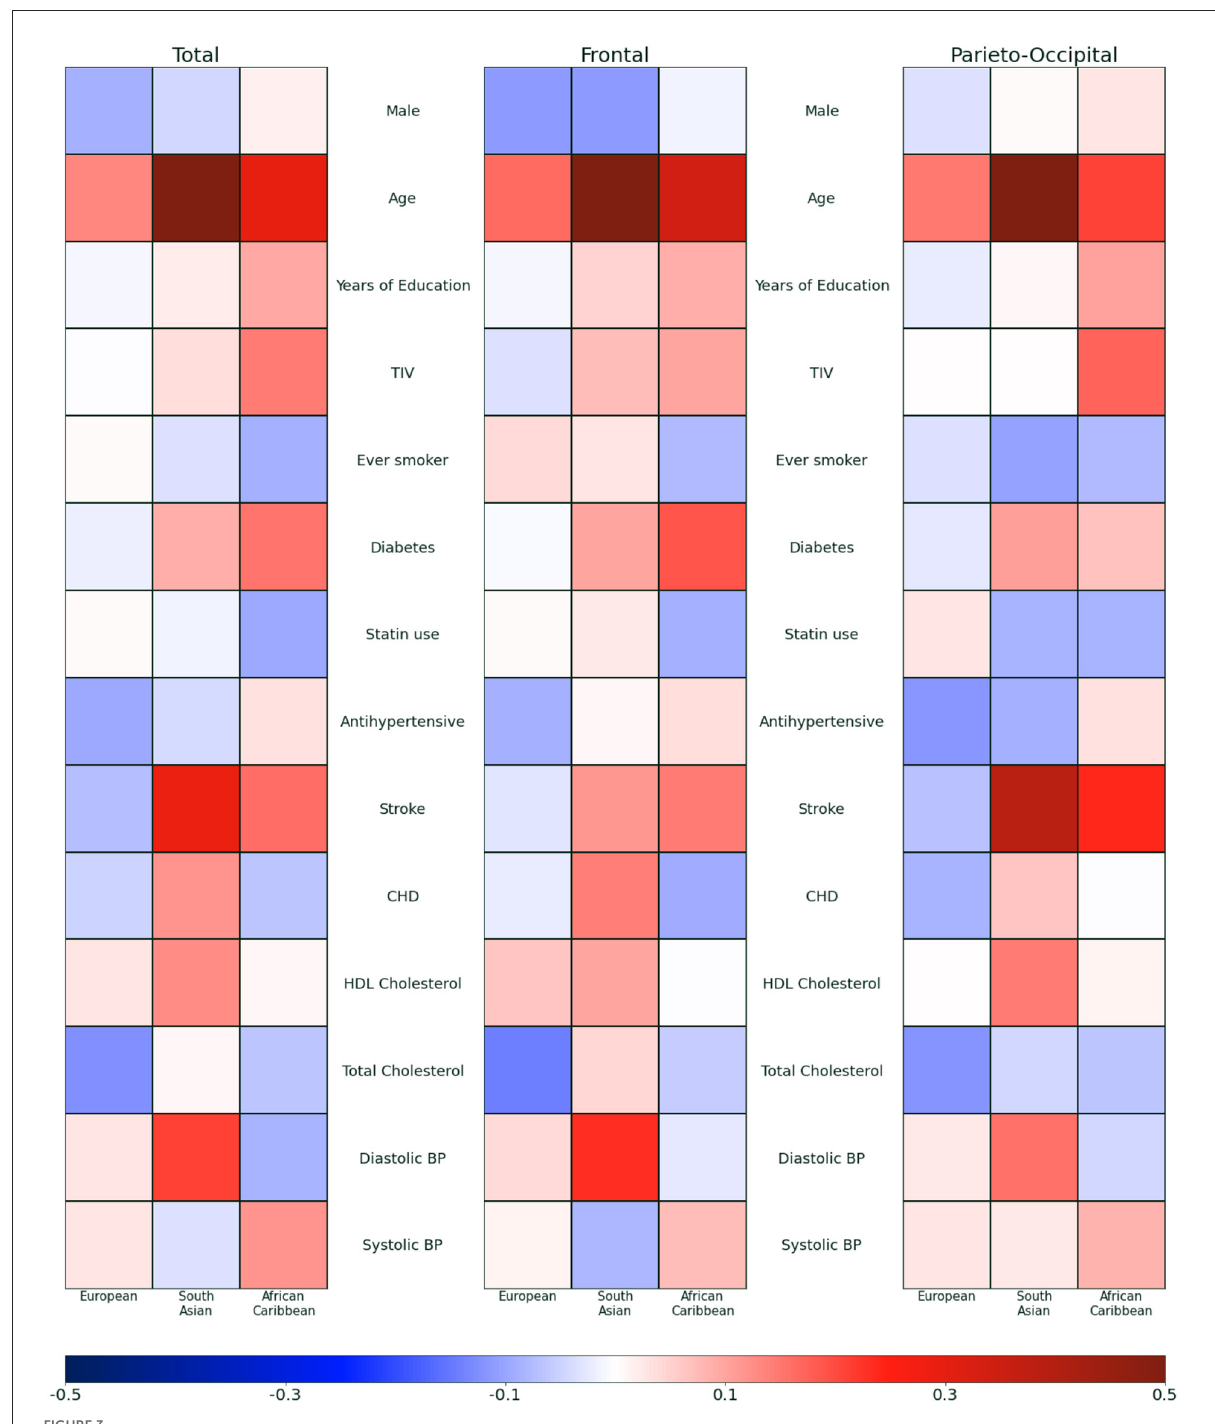
FIGURE3 Effect size of demographic and cardiovascular risk factors on white matter hyperintensity volumes overall and in frontal and the parieto-occipital lobes. A separate model is fitted for each ethnicity adjusting simultaneously for all covariates. TIV, Total Intracranial Volume; BP, Blood pressure; CHD, Coronary Heart